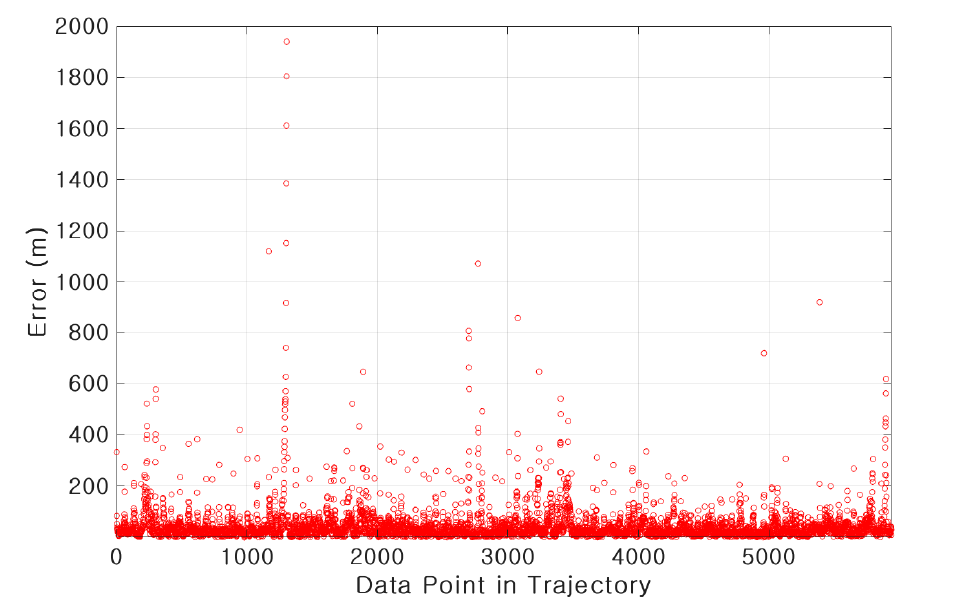
( b ) Error scatter plot for group A using Bi-LSTM.